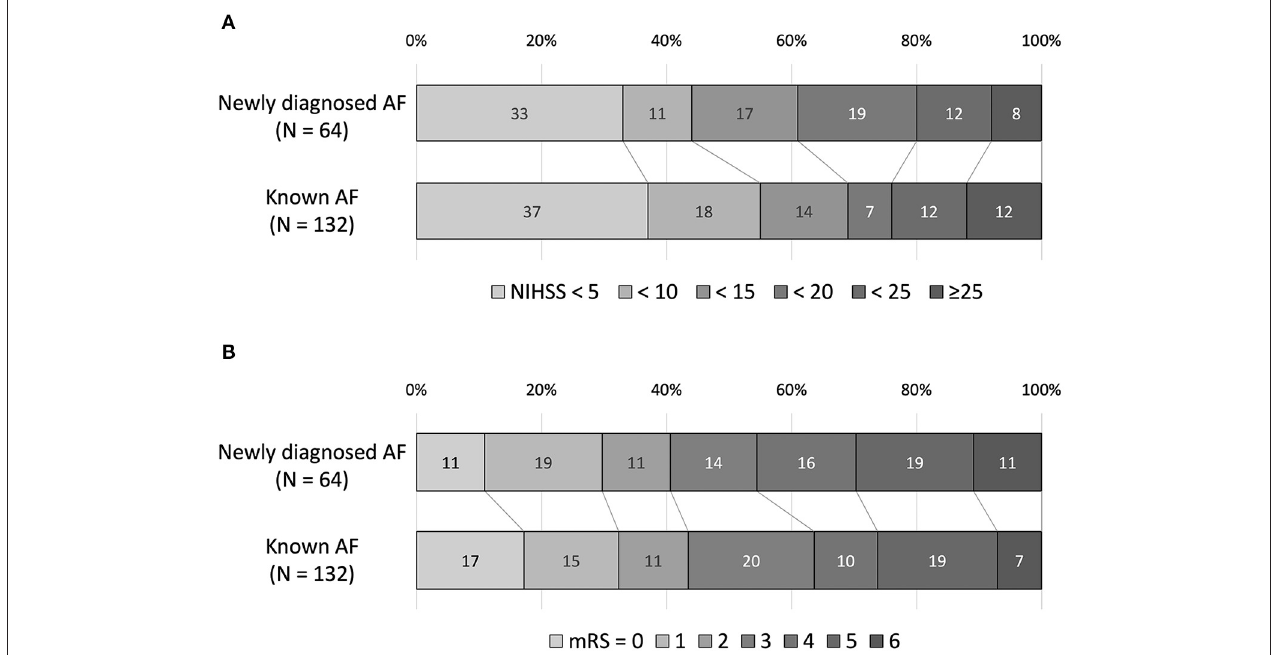
FIGURE 2 | The National Institutes of Health Stroke Scale (NIHSS) score on admission (A) and the modified Rankin Scale (mRS) score at discharge (B) . There was no difference in the NIHSS score on admission and the mRS score at discharge between the two groups.